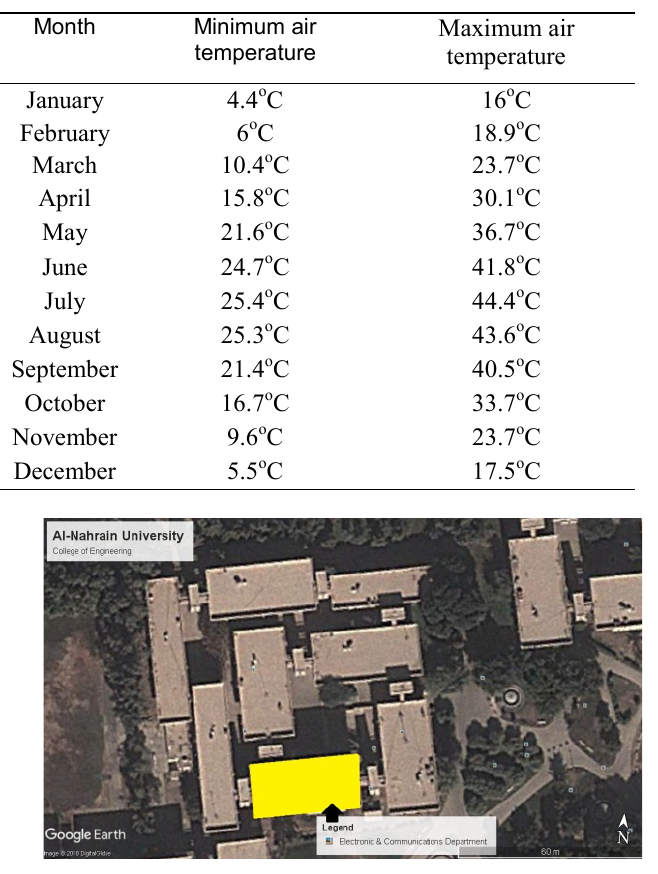
Table 2. The monthly values of temperature in Iraq [8].